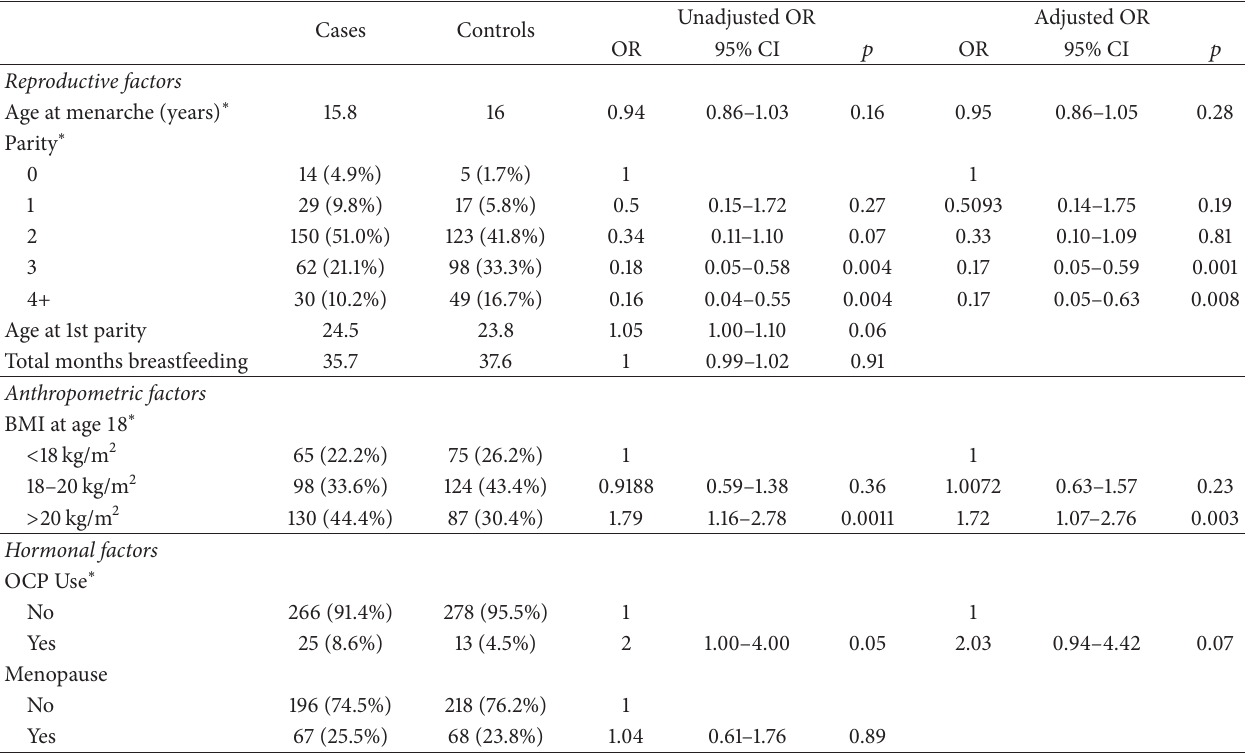
Table 3: Conditional logistic regression analysis to estimate the odds (odd ratio, OR) of breast cancer.